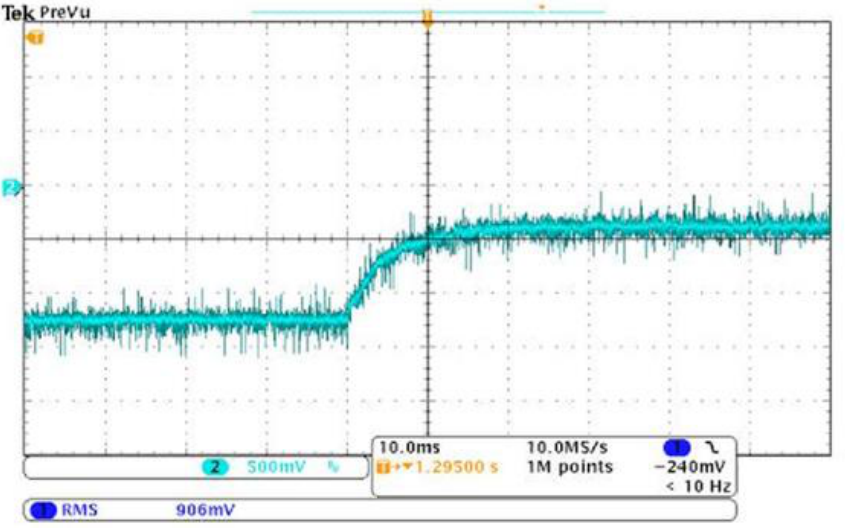
Figure 15. Zoom on a positive bus current transient, responding to an instantaneous positive command.